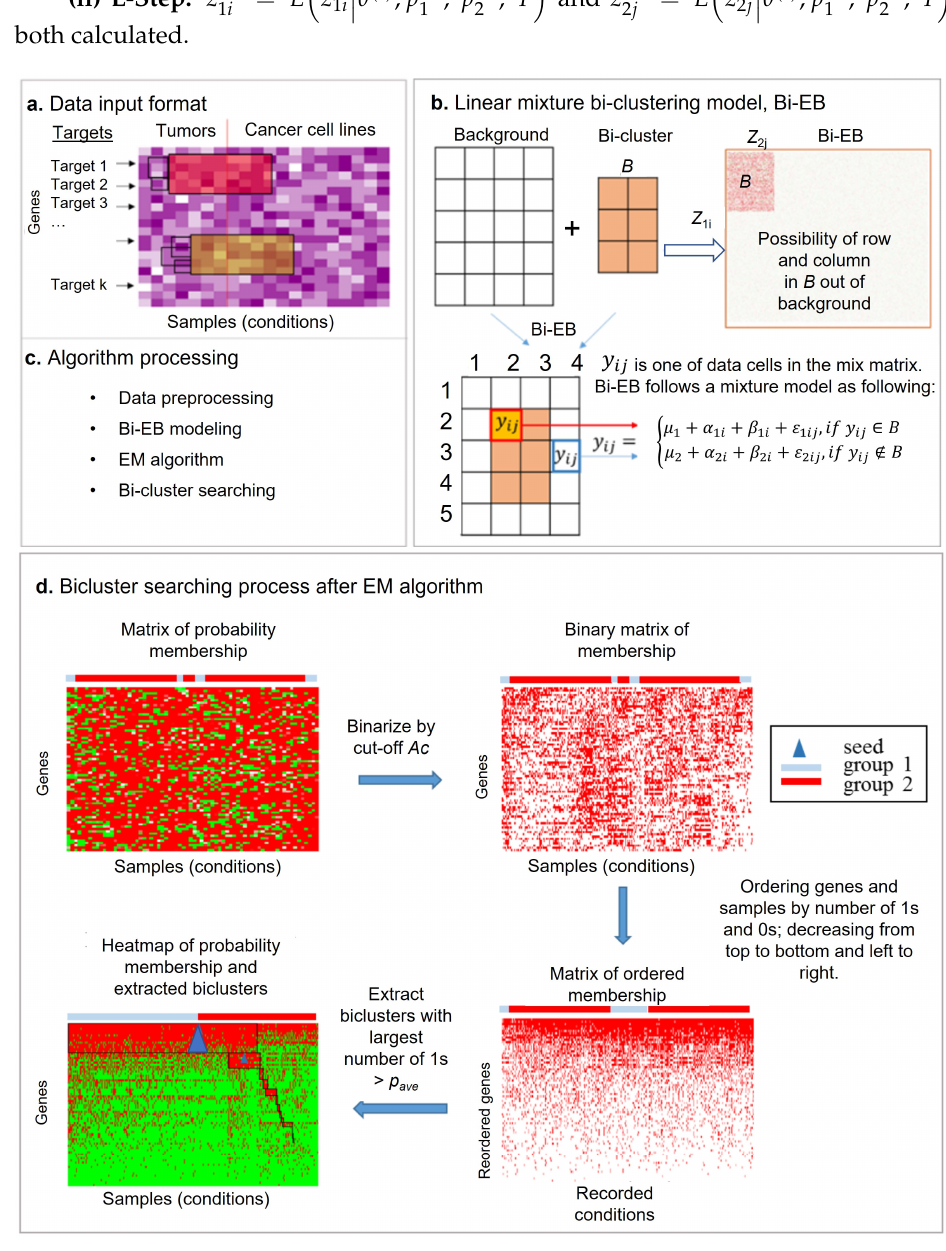
Figure 1. The empirical Bayes model is used to identify the co-regulation biclusters across tumors and cancer cells, both for target module detection. ( a ) Input data for the Bi-EM algorithm (the row is the gene list, and the column is sample list from different groups or conditions); ( b ) linear mixture biclustering model illustration (Bi-EM), where the bicluster signals are extracted from background- originating rows and columns, respectively. The mixture model is constructed to identify these biclusters where its grand mean µ 1 is the difference from the background mean µ 2 significantly. ( c ) Four processing steps of the Bi-EB algorithm. ( d ) The Bi-EB algorithm searching process. We need to calculate the row and the column possibility in a bicluster and denote each pixel (dot in matrix) in the bicluster as 1 (yes, ≥ Ac or 0 (not, < Ac ) by cut-off Ac . The Bi-EB algorithm can identify multiple biclusters sequentially with the associated seed. Each iteration can only identify one bicluster. The bicluster size is based on the number of 1s > p ave (the average possibility of row and column in biclusters). The next bicluster search is based on the left information of rows and columns (the current bicluster